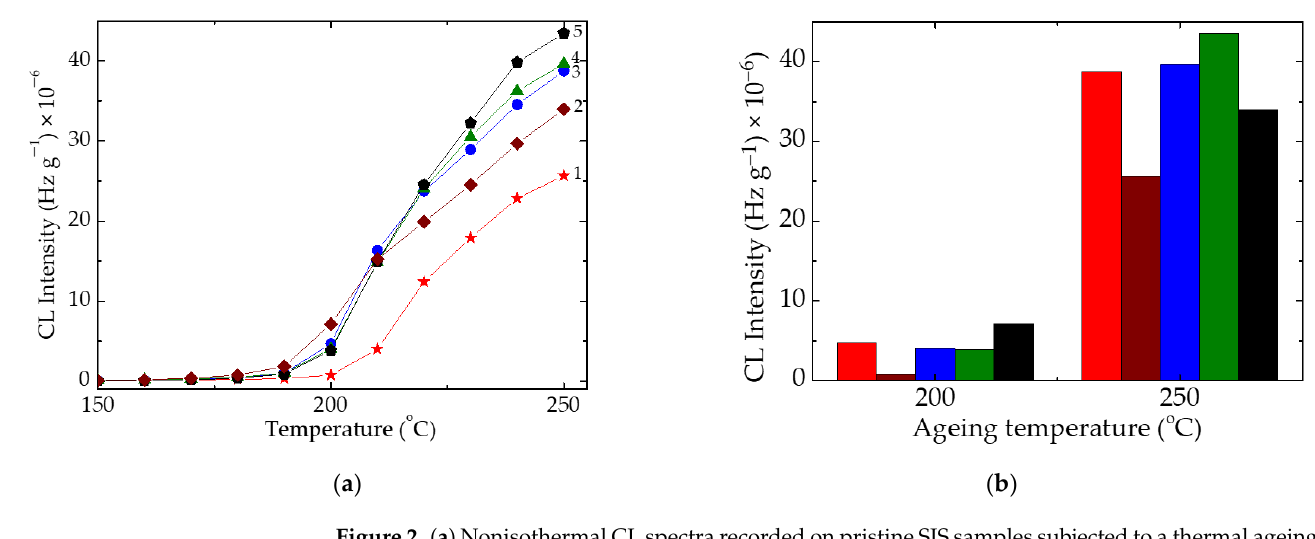
Figure 2. ( a ) Nonisothermal CL spectra recorded on pristine SIS samples subjected to a thermal ageing treatment at 80 °C at various heating times. (1) 0 h; (2) 5 h; (3) 10 h; (4) 15 h; (5) 20 h. Measurement heating rate: 10 °C·min −1 ; ( b ) histogram of CL intensity determined at two main temperatures (the color code is identical for the both figures).